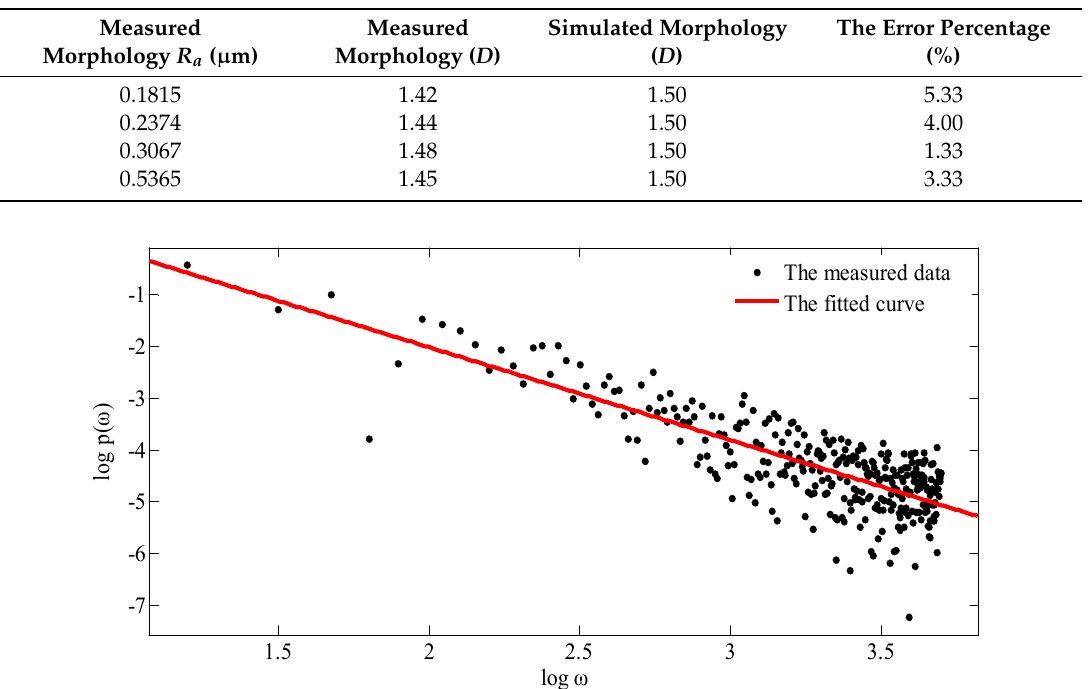
Figure 14. Double logarithmic power spectrum curve.